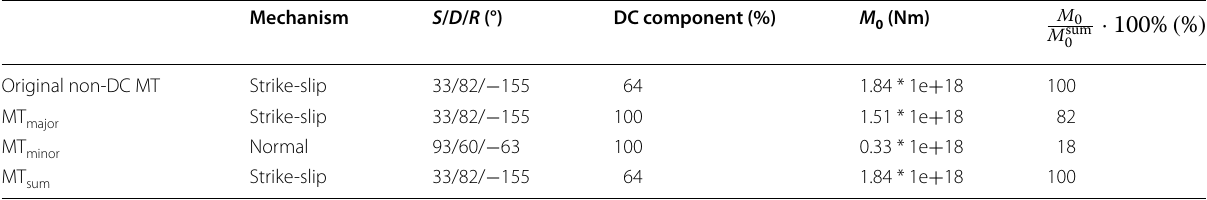
Table 5 Decomposition of non‑DC MT of the M decomposition by Eqs. (13) and (14) preserving MT T ‑axis